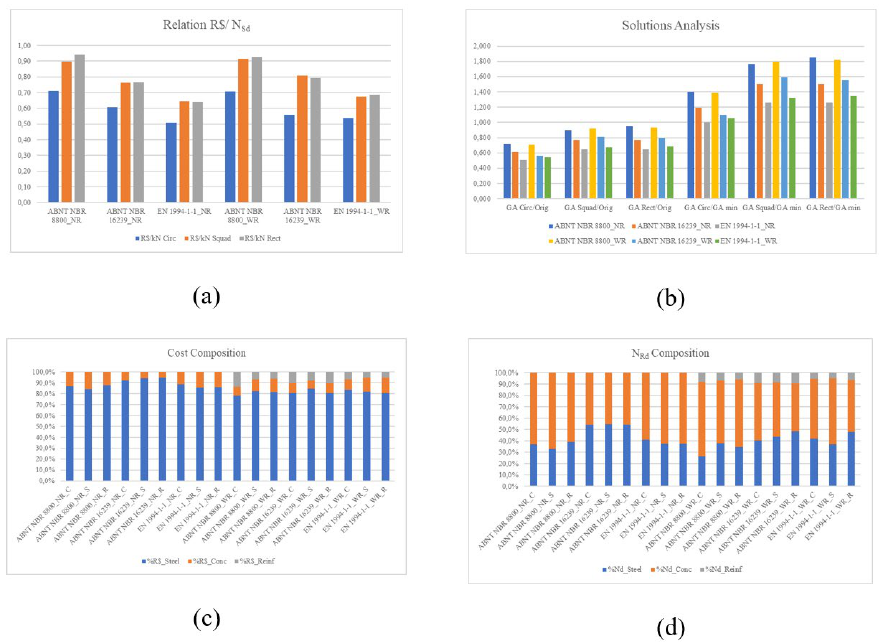
Figure 7 – (a) Ratio R$/NSd; (b) Ratio AG/Original Solution; (c) Cost composition of composite filled columns (d) Composition of the resistance to normal forces of the composite filled